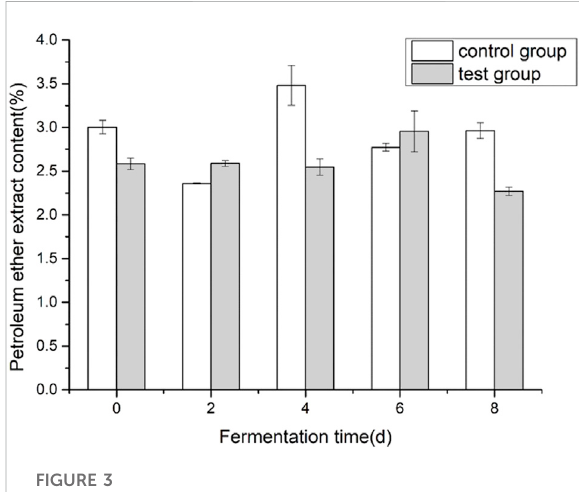
FIGURE 3 Effects of fermentation medium on thecontentof petroleum ether extract from cigar